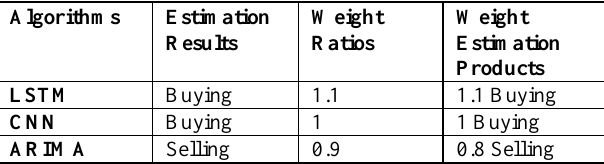
Table 3: Boost Functional Cluster Weighting